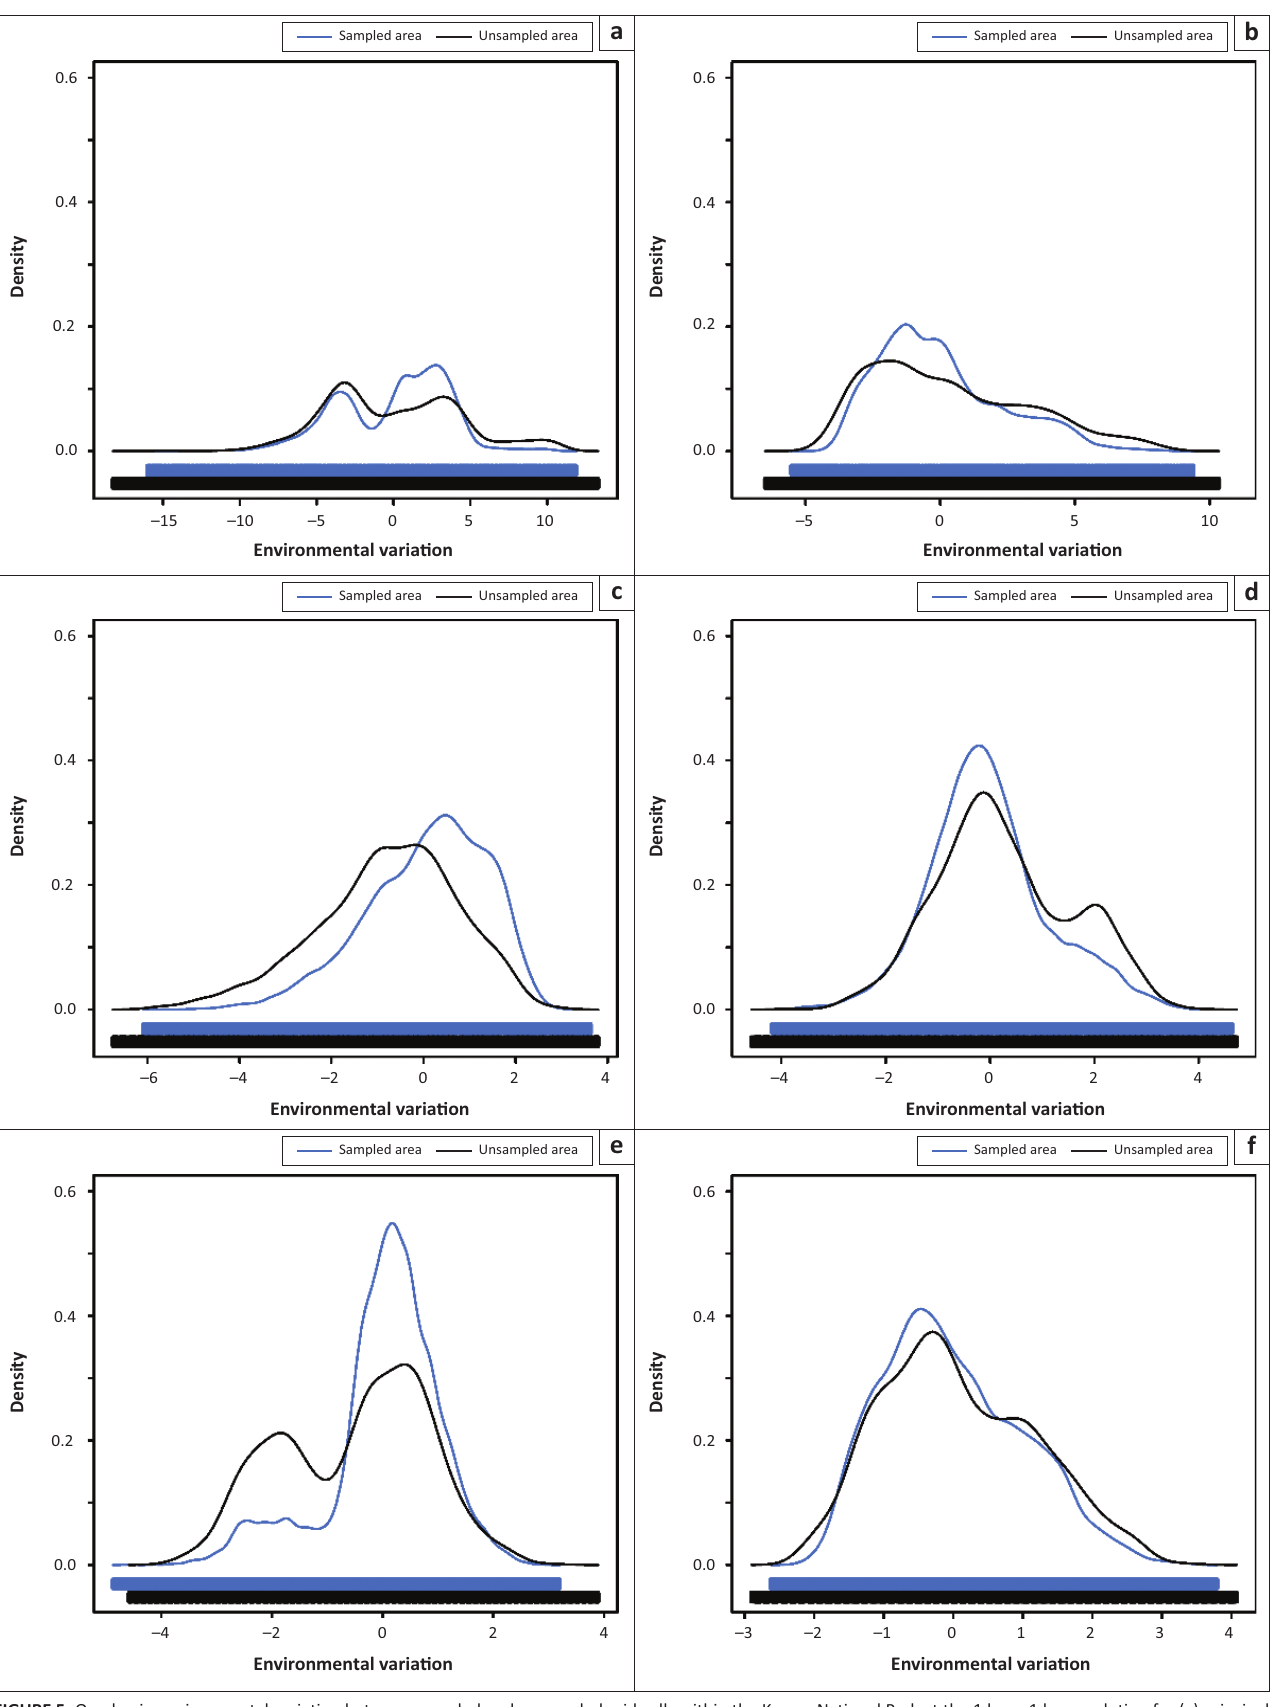
FIGURE 5: Overlap in environmental variation between sampled and unsampled grid cells within the Kruger National Park at the 1 km × 1 km resolution for (a) principal component 1, (b) principal component 2, (c) principal component 3, (d) principal component 4, (e) principal component 5, and (f) principal component 6. Bars beneath kernel density plots represent the range of environmental variation between sampled and unsampled grid